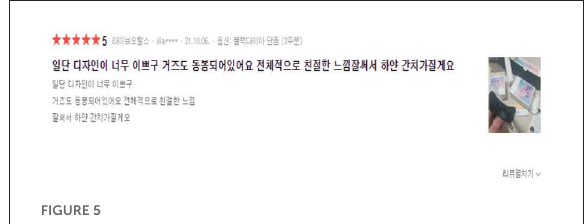
FIGURE5 Example of a comment in Naver shopping mall platform.